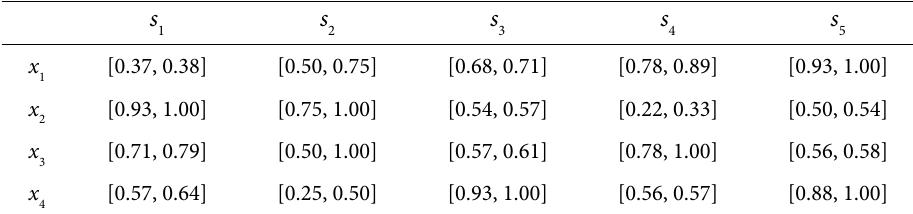
Table 5. Normalized uncertain decision matrix